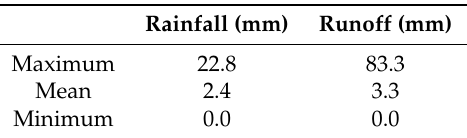
Table 2. Maximum, mean and minimum of rainfall and runoff accumulations between 1300 and 1500 UTC on 18 July 2017 (T + 22–T + 24) forecasts. The values are generated from an ensemble (run with the MetUM) with 144 members (further details in references [59,60])*. The values are taken from all members and all points within a 26 × 26 grid points (57.2 km × 57.2 km) region, as all of these accumulations are equally valid over the grid point containing Coverack. Both the rainfall and the runoff have been generated by the